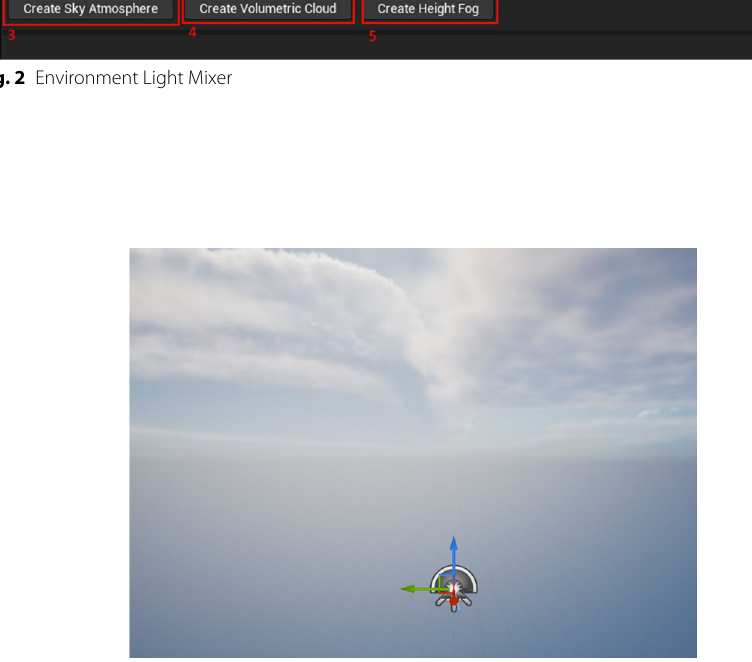
Fig. 3 Environment after using the Environment Light